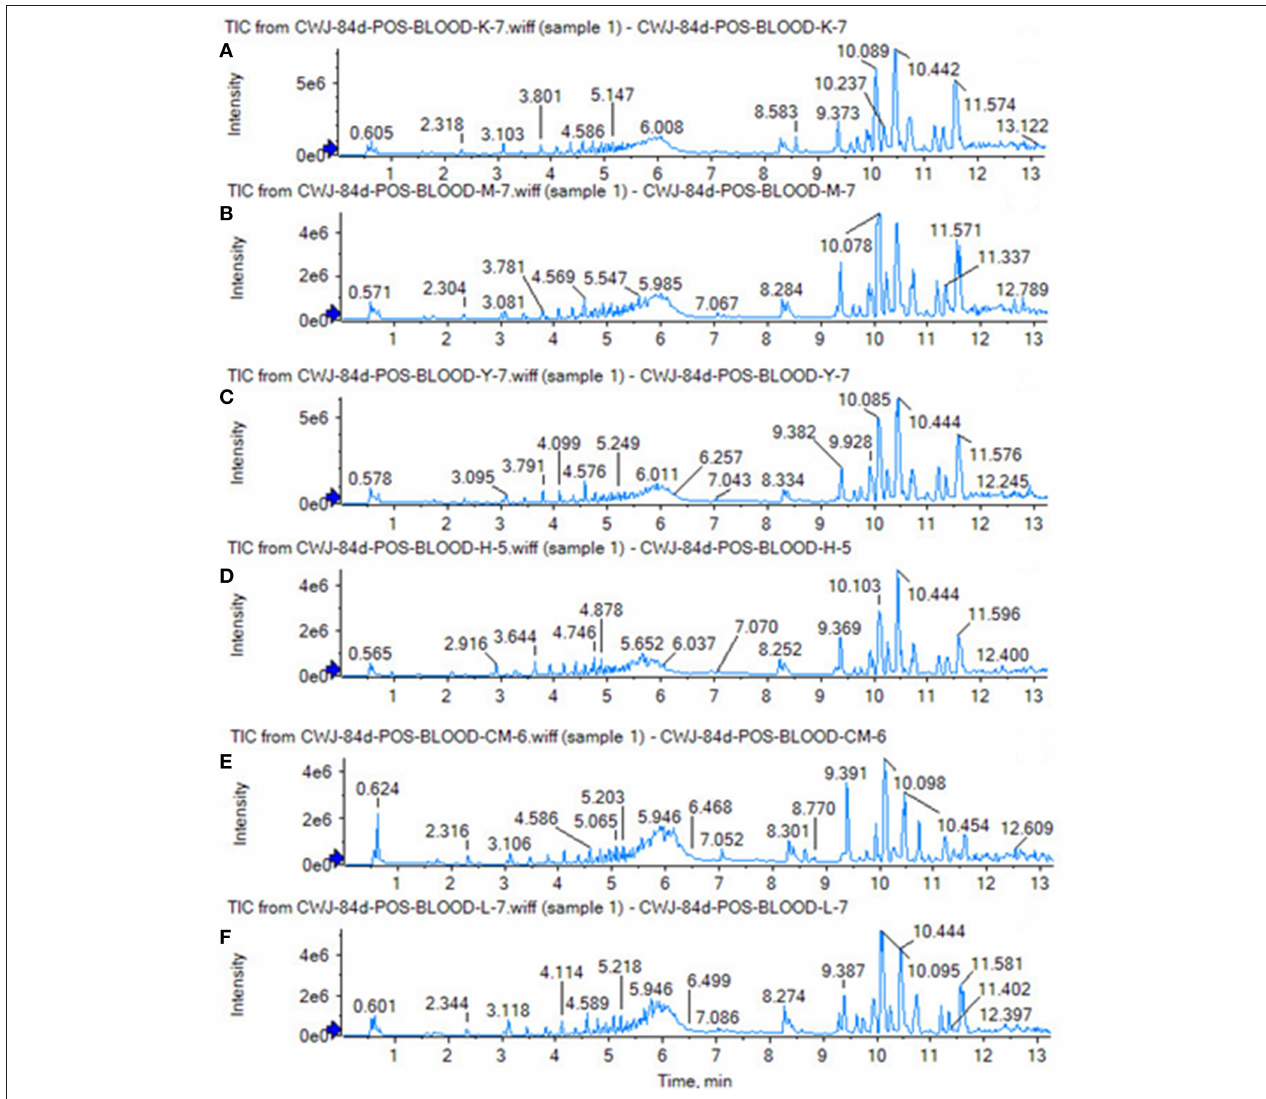
FIGURE 9 | TIC of total lignans on the ovariectomized osteoporosis rat model in positive ion mode. (A) Sham operation group; (B) OVX Model group; (C) NYL; (D) ASSLH; (E) ASSLM; (F) ASSLL.